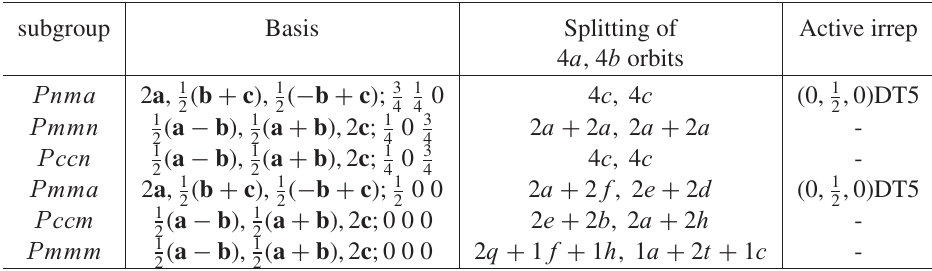
Table 5. Possible centrosymmetric orthorhombic subgroups of F m ¯3 m fulfilling the lattice metrics observed in the orthorhombic phase of fullerene-cubane crystals. The third column indicates the resulting Wyckoff splitting for the two sites occupied by the centres of the fullerene and cubane molecules. The fourth column shows the corresponding active irrep of the order parameter, in the case that the subgroup is an isotropy subgroup. The third and fourth columns are results obtained with SYMMODES